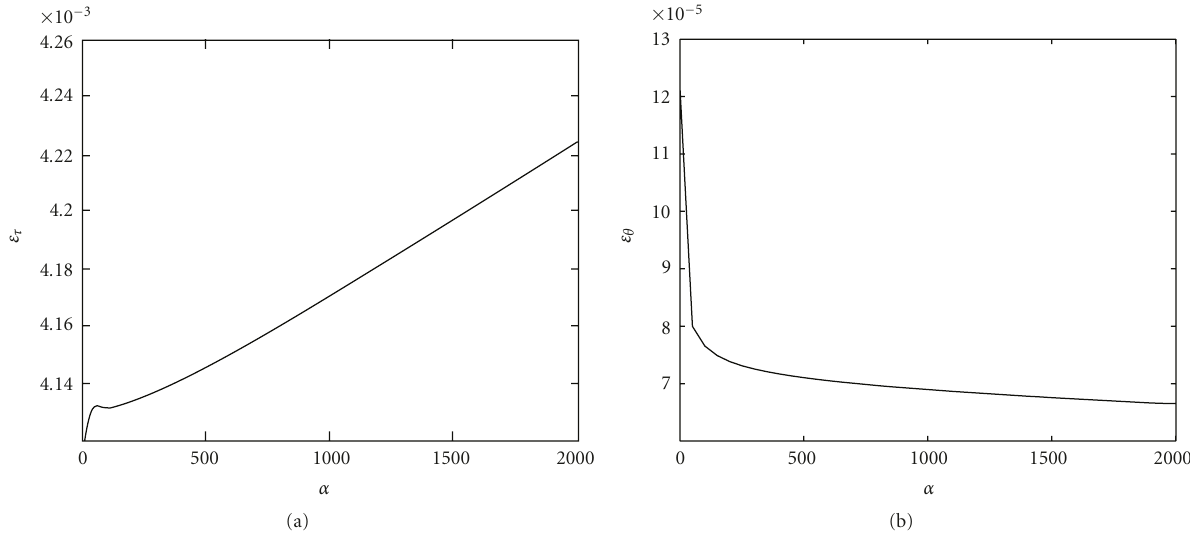
Figure 2: Curves of (a) ε τ and (b) ε θ when α varies from 1 to